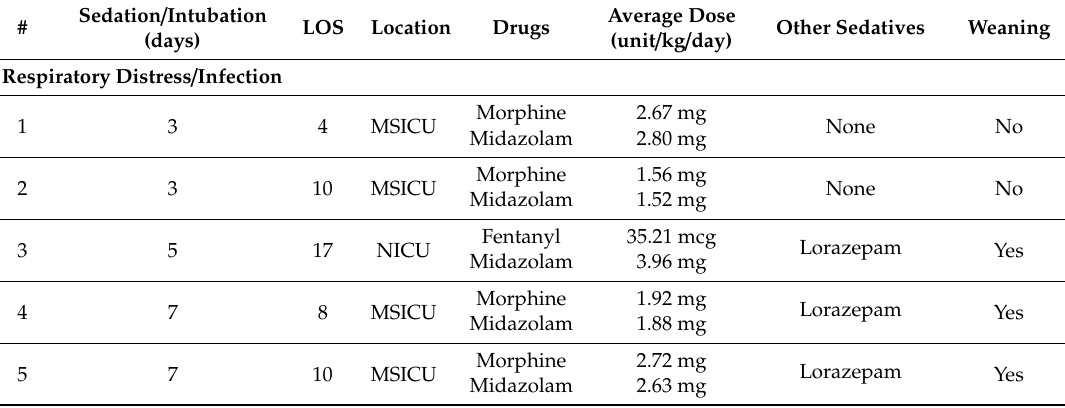
Table 2. Patients undergoing respiratory disease sedation treatment. Patients with respiratory diseases are arranged according to disease category (respiratory distress / infection vs. other) and length of sedation. Data includes sedation treatment and weaning for each infant from a single hospital admission at Boston Children’s Hospital; infants did not require multiple hospital admissions. Sedation period coincided with intubation. All patients were sedated with a combination of opioids (fentanyl and / or morphine) and benzodiazepine (midazolam), irrespective of intensive care location. Average daily dose (unit / kg / day) is defined as the average daily total dose of each drug received both as an infusion and boluses. Other additional pain and sedation medications such as clonidine, dexmedetomidine, and lorazepam (administered in the form of boluses, unless otherwise stated) were administered according to physician and / or care service preference. Patients with sedation < 5 days ( n = 2 / 10) did not require drug weaning following